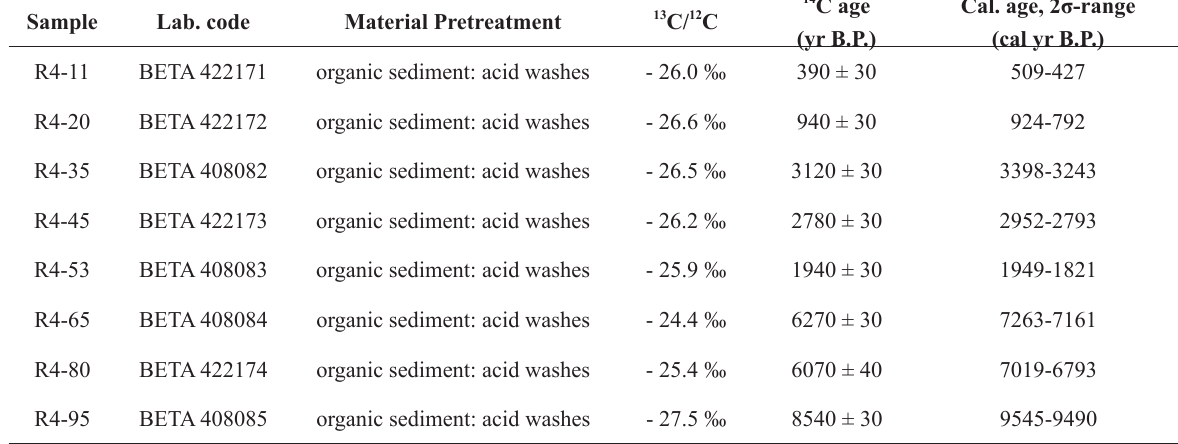
Radiocarbon dates (AMS) of the samples from the Serra Sul dos Carajás.